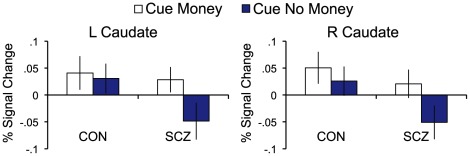
Cue-related activation in bilateral caudate ROIs.Activation shown is mean activation across voxels within regions of interest. Error bars represent standard error.